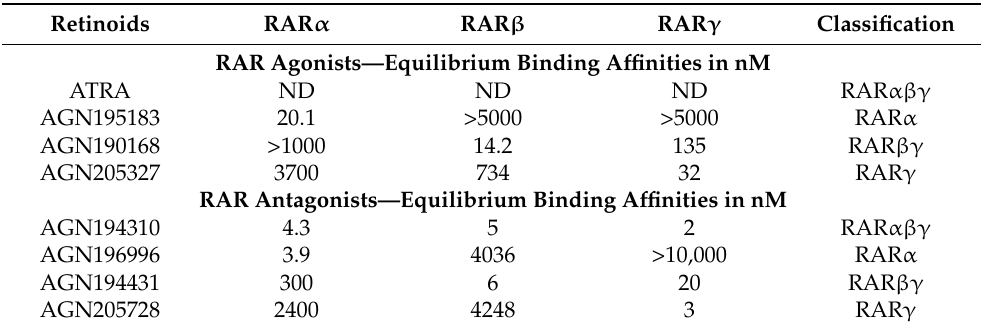
Table 1. Binding affinities (ED 50 in nM) of selected retinoids against RARs. Nuclear extracts were